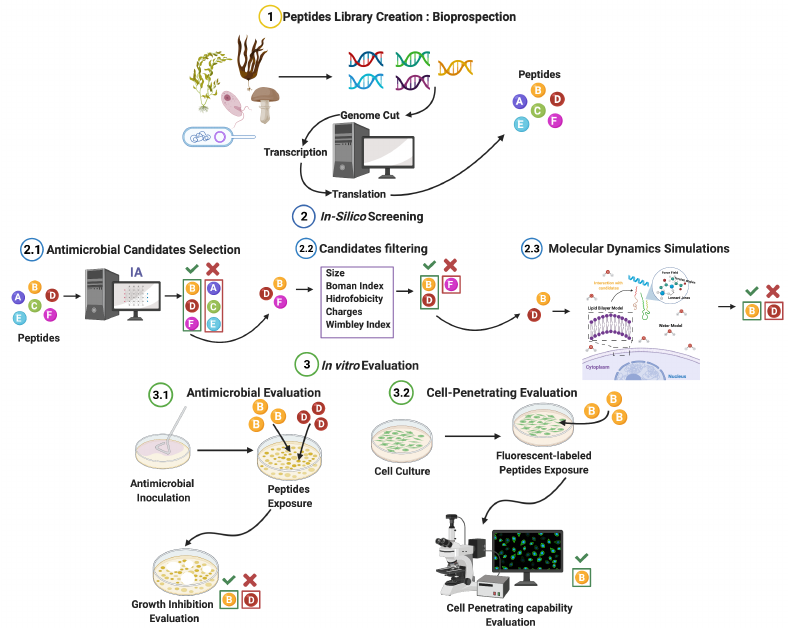
Figure 1. AMPs rational discovery pipeline. (1) A peptide library was generated by cutting the Escherichia coli genome in silico. (2.1) The improved DL algorithm analyzes the library to select promising candidates with membrane activity. (2.2) Candidates were filtered using physicochemical properties to obtain viable AMPs. (2.3) Molecular Dynamics was implemented to find candidates exhibiting cell-penetrating capability. (3.1) AMPs candidates were evaluated in vitro to obtain the MIC. (3.2) Peptides with additional cell-penetrating activity were evaluated in mammalian cells via confocal microscopy. Created with Biorender.com.